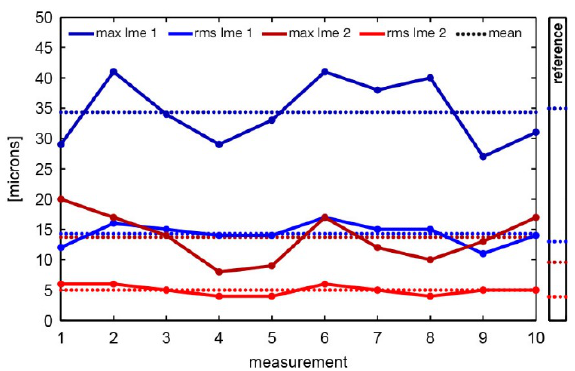
Figure 16. Quality characteristics (template matching)